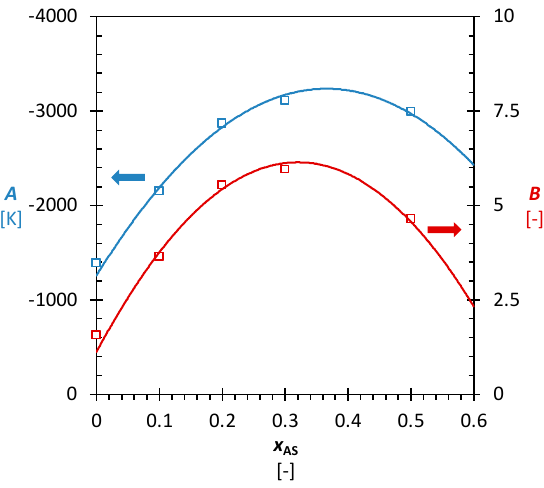
Figure 5. The points are the parameters A (blue) and B (red) for the Na 2 BrO 3 system from the fits of the datasets at each antisolvent fraction x AS to Equation (2). The lines are the antisolvent faction dependent parameters A (blue) and B (red) determined from a fit of the entire dataset of the Na 2 BrO 3 system to Equation (3) with n = 2. The parameters can be found in Table 1.